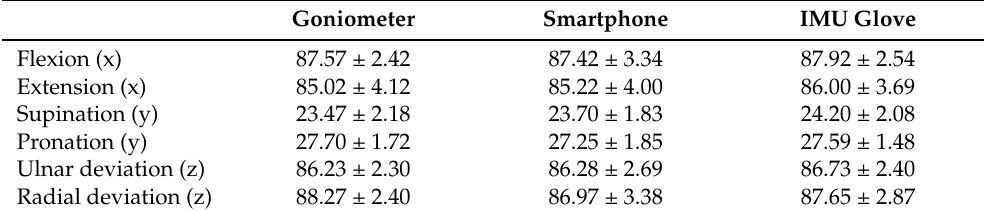
Table 1. The means of active wrist range of motion movements measured with the three devices.